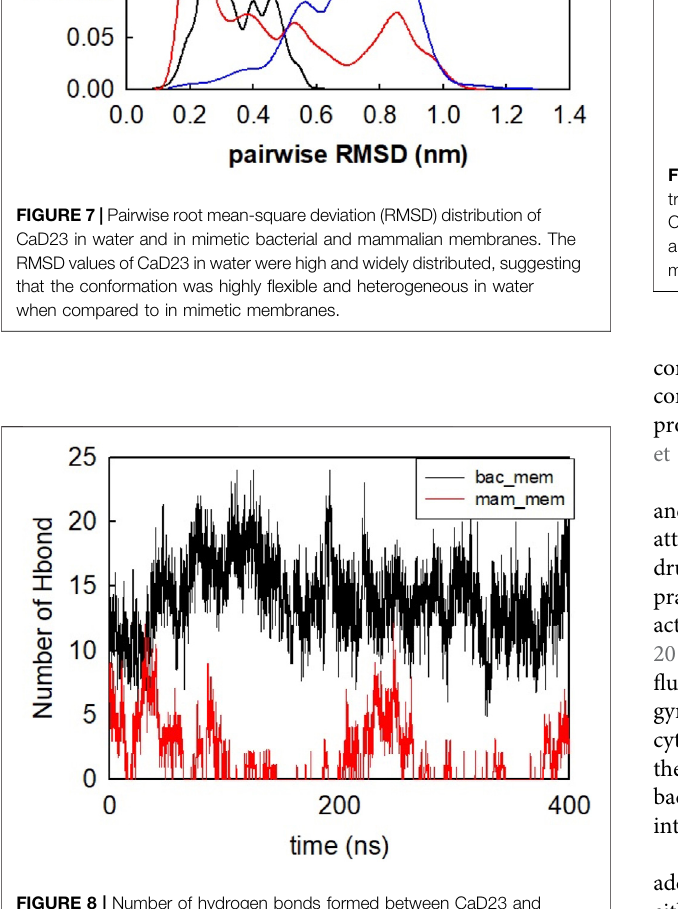
FIGURE 8 | Number of hydrogen bonds formed between CaD23 and the two membranes during the last 400 ns